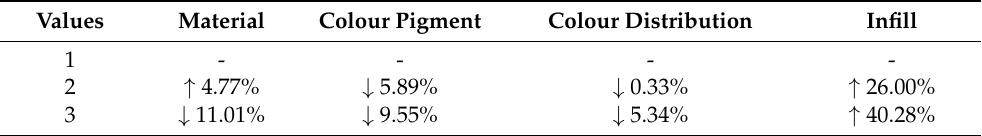
Table 1 (1 — PLA, 2 — PLA+, 3 — PETG; 1 — blue, 2 — red, 3 — green; 1 — 33%, 2 — 66%, Table 5. Tensile strength variation Table 5. Tensile strength variation degree.